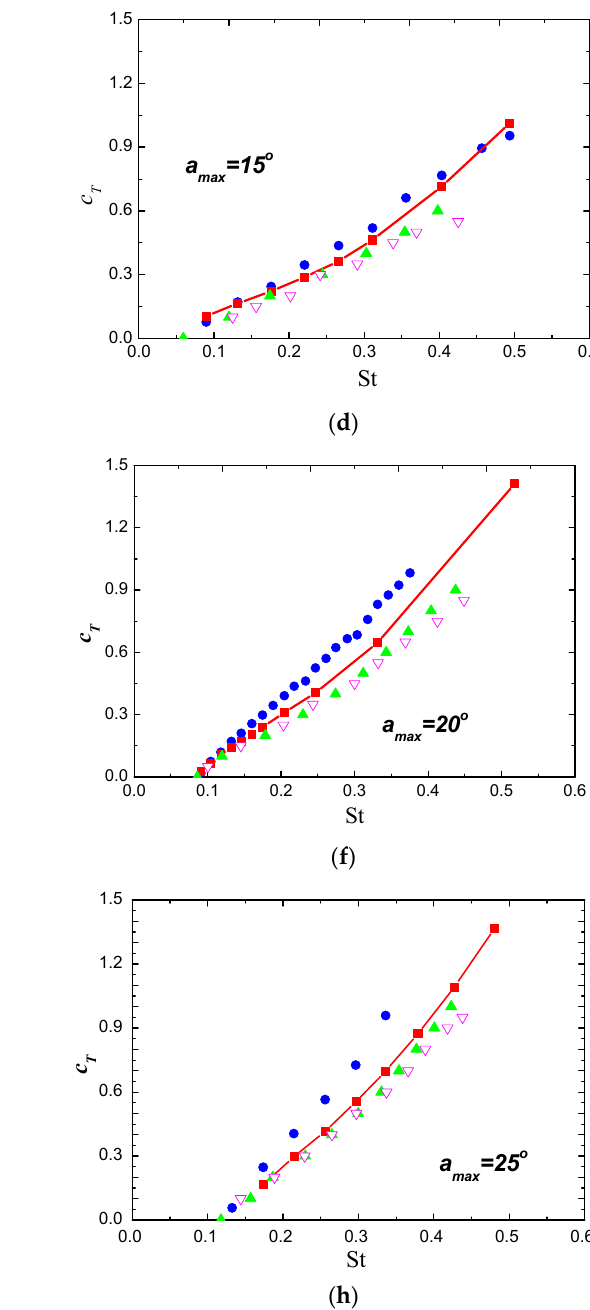
( b ) Numerical results in the current work. Figure 10. Vorticity pattern visualized in the foil wake, for St = 0.45, a max = 20°.